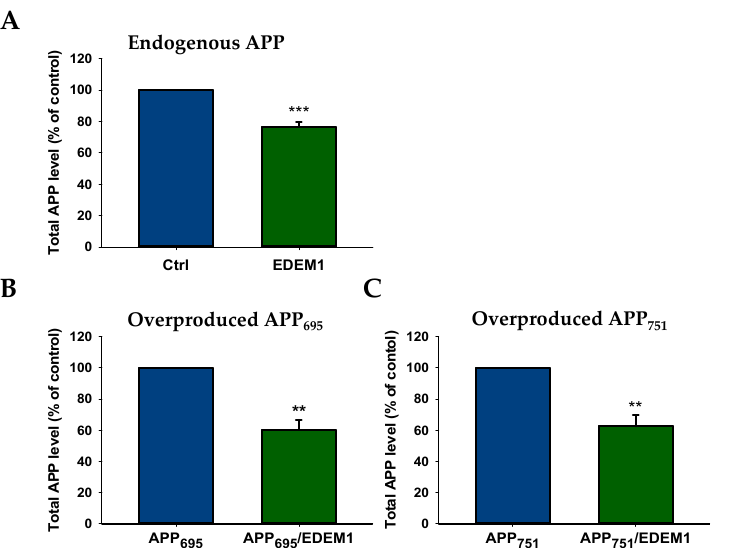
Figure 2. Total amount of APP is decreased in EDEM1-transfected HEK293 cells. ELISA analysis of ( A ) endogenously expressed APP, ( B ) overproduced APP 695 , or ( C ) overproduced APP 751 in lysates from cells with or without EDEM1 cotransfection. The values are expressed as mean ± SD, n = 3, ** p ˂ 0.01, *** p ˂ 0.001, Student’s t test. EDEM1 overexpression and equal β -actin levels were assessed by Western blotting, as indicated in Figure 3.